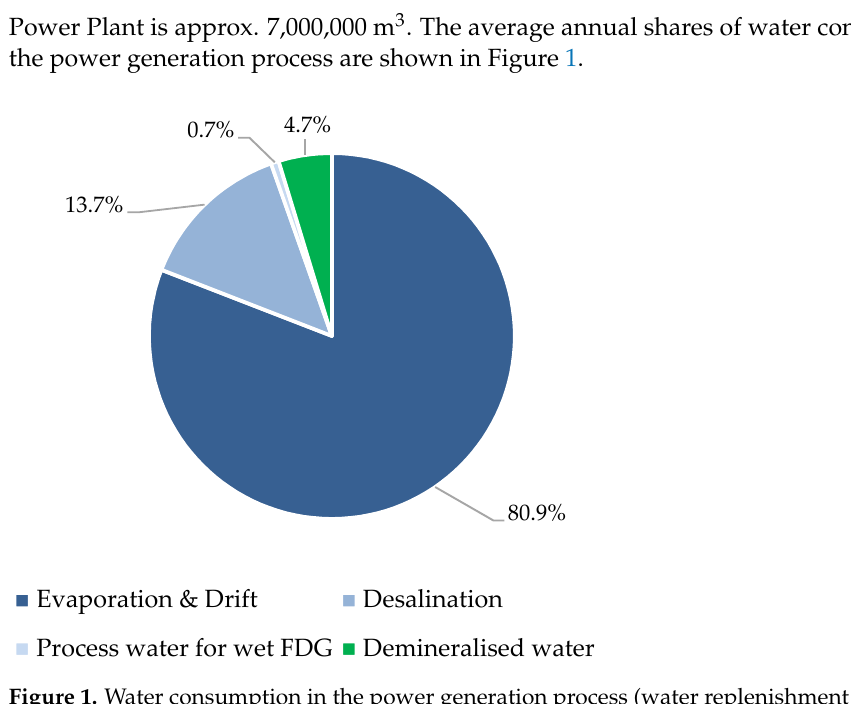
Figure 1. Water consumption in the power generation process (water replenishment in the cooling circuit is shown in blue, water replenishment in the boiler circuit is shown in green).